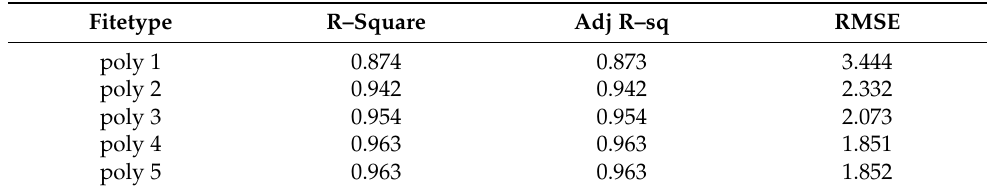
Table 1. Polynomial fitting analysis with different